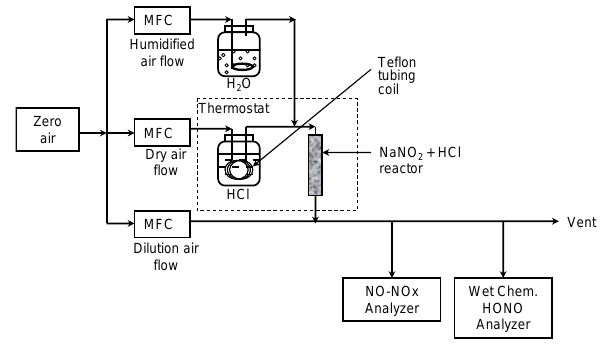
Figure 1. Schematic of a HONO generation system. MFC represents a mass flow controller. 707 Fig. 1. Schematic of a HONO generation system. MFC represents a mass flow